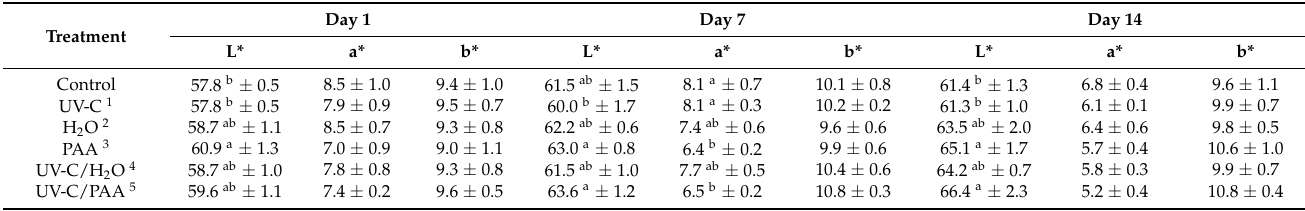
Table 5. LSM ± SE of the lightness (L*), redness (a*), and yellowness (b*) values of pork after UV-C, peracetic acid (PAA) and H 2 O treatment alone and in combination, inoculated with Brochothrix thermosphacta , after 1, 7, and 14 days of storage ( n = 3). Treatment